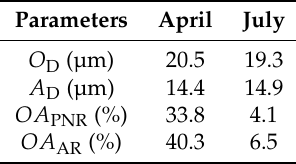
Figure 8. SEM images: ( a ) April 2017; ( b ) July 2017. Table 2. SEM image parameter